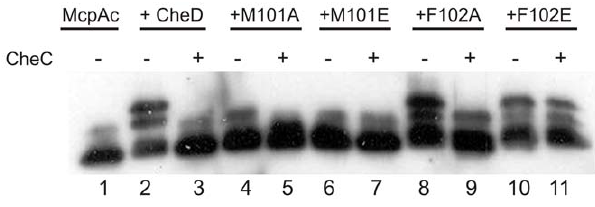
Figure 3. Western blots of invitro deamidation assays of McpAc show CheD-mediated receptor modifications. Deamida- tion of the receptor fragment results in higher-migrating bands on a polyacrylamide gel. CheC is added, as indicated, and inhibits deamidation. Lanes 2 and 3 show McpAc incubated with wild-type GST-CheD, and lanes 4–11 show McpAc incubated with various GST- CheD mutants.